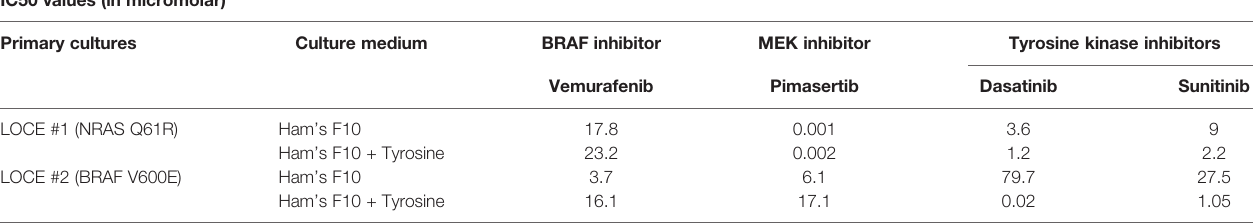
TABLE 2 | Phenotype switching and drug